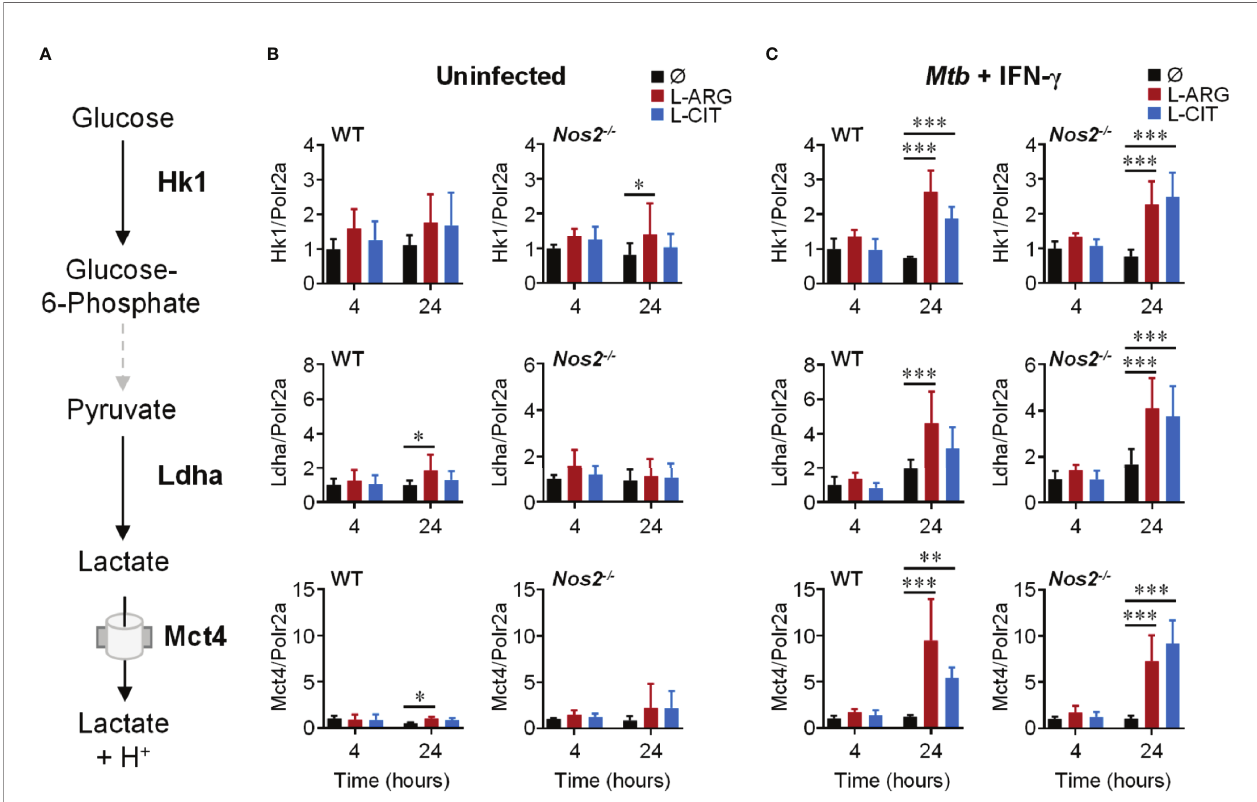
FIGURE 3 | Transcriptional regulation of glycolysis genes by L-arginine/L-citrulline. (A) Schematic of glycolysis leading to lactate production and release from macrophages. (B, C) qRT-PCR analysis of uninfected PM F s (B) or following Mtb H 37 R v (MOI~1) infection and IFN- g stimulation (C) from C57Bl/6 (WT) or Nos2 -/- mice, cultured in R-free C-DMEM containing 400 m M L-arginine, L-citrulline, or neither amino acid (Ø). Gene expression is normalized to Polr2a. Data are the mean fold gene expression compared to 4 hour, neither amino acid data (N ≥ 5, two experiments combined). *p < 0.05, **p < 0.01, ***p < 0.001 by 2-way ANOVA with Sidak ’ s post hoc test. Error bars,